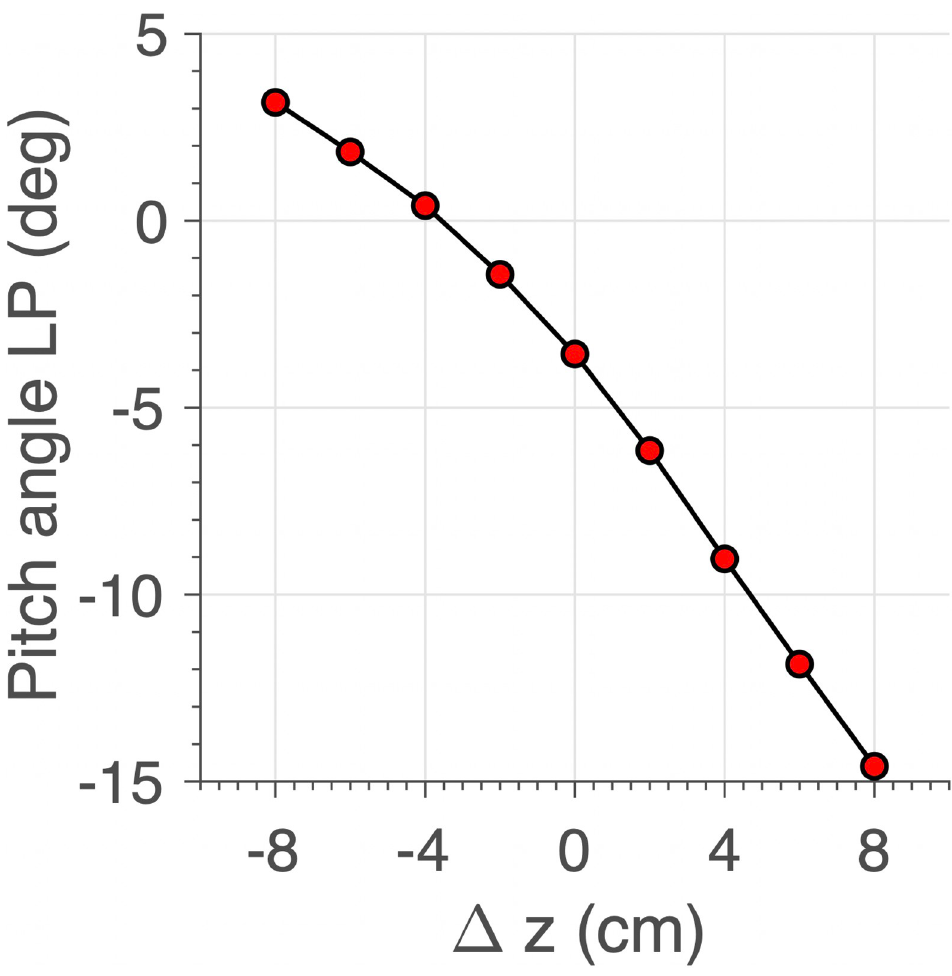
Fig 16. The pitch angle of Listing’s plane varies systematically with the craniocentric insertion points of the muscles re. eye’s horizontal plane. Negative values: downward pitch